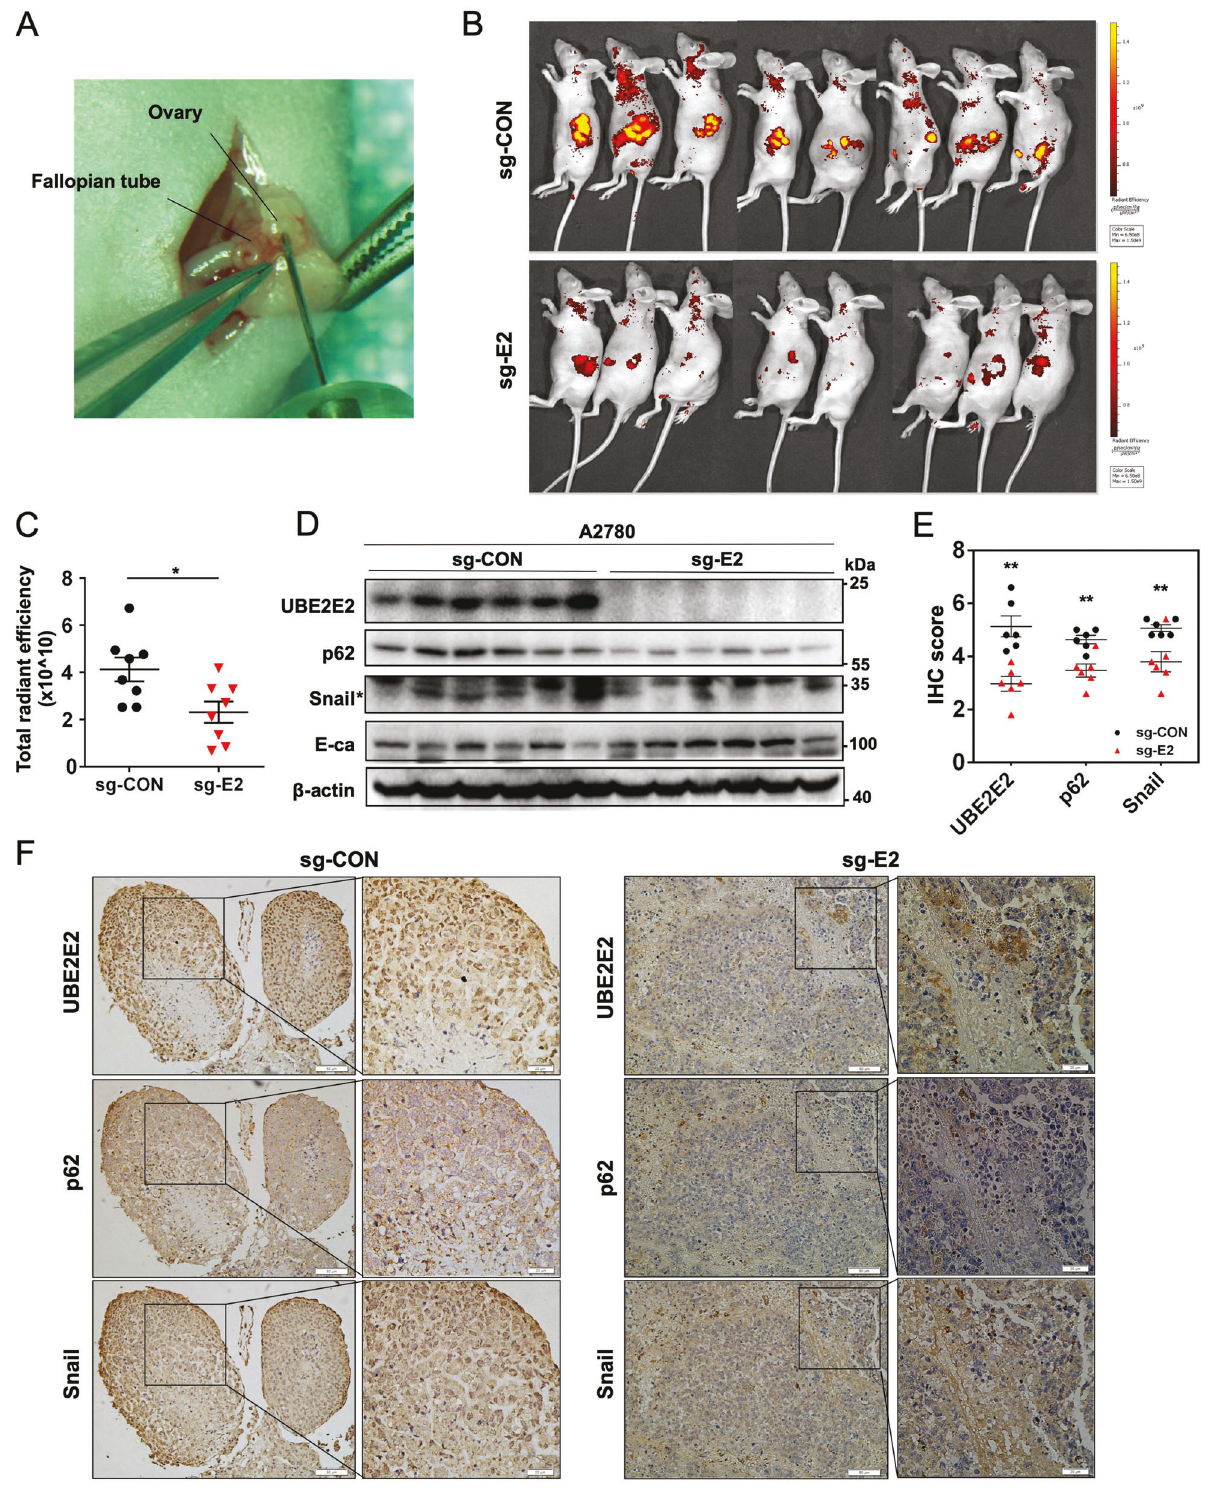
Fig. 7 Loss of UBE2E2 expression inhibits OvCa cell invasion and proliferation in vivo. A Illustration of orthotopic implantation of A2780 cells into ovarian bursa. B Fluorescence imaging of the tumor site (radiant ef fi ciency, [p/s/cm 2 /sr]/[ μ W/cm 2 ]) ( n = 8). C For fl uorescence quanti fi cation, regions of interest (ROIs) were drawn with Living Imaging 3.0 software, and the total radiant ef fi ciency was determined (* p < 0.05). The expression of the p62, Snail, and E-cadherin proteins in xenograft tumors was explored by ( D ) western blot and ( E ) immunohistochemical (IHC) analyses ( n = 6, ** p < 0.01). The asterisk indicates the protein band of Snail. F Representative IHC images of tumor samples collected from sacri fi ced mice (×20 magni fi cation, scale bar = 50 μ m; ×40 magni fi cation, scale bar = 20 μ m).